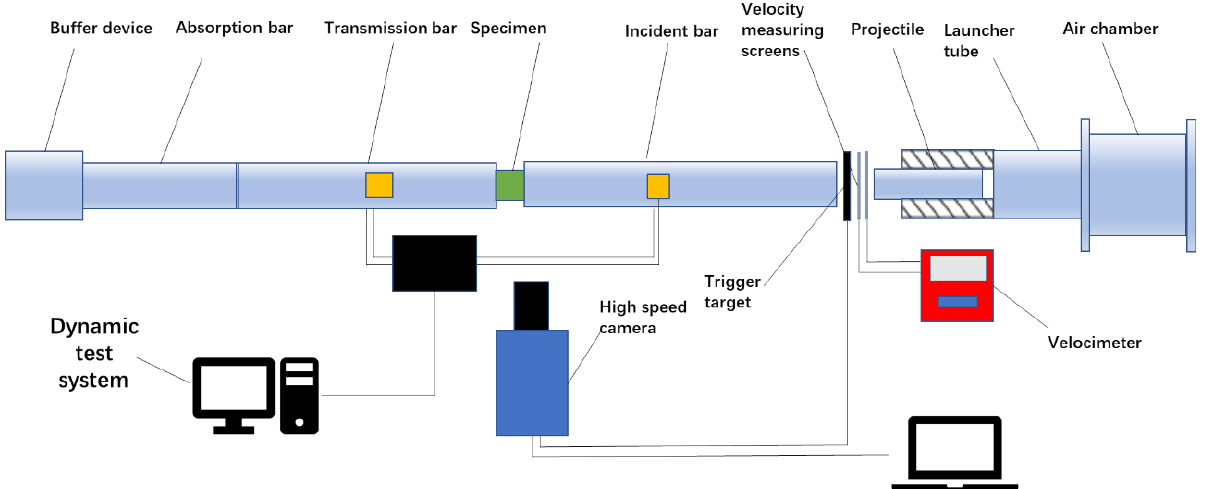
Figure 2. Schematic diagram of split-Hopkinson bar experimental device.